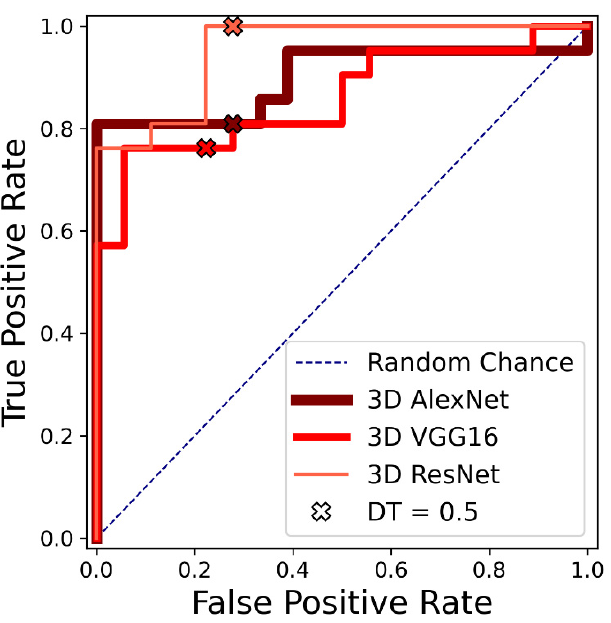
Figure 3. Experiment 1: Receiver operating characteristic (ROC) curves for 3D VGG, 3D AlexNet and 3D ResNet on one test fold of the first dataset. Performance with discrimination threshold (DT) = 0.5 is marked with an x for each network.